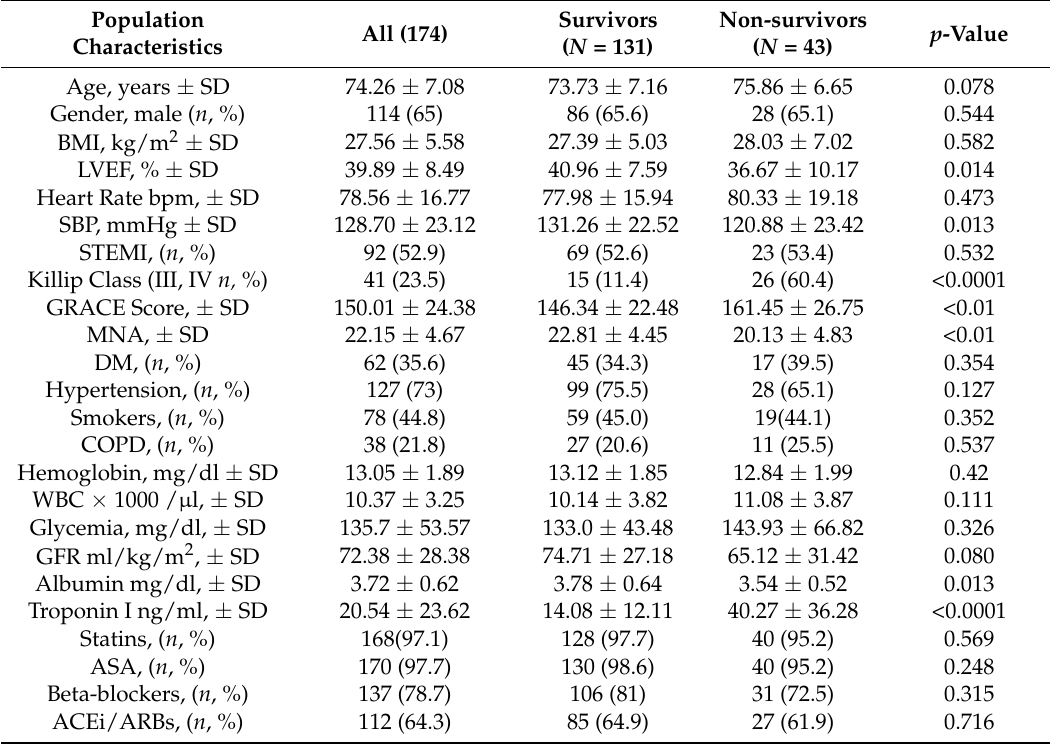
Table 1. Characteristic of patients in the overall study population, stratified as survivors and